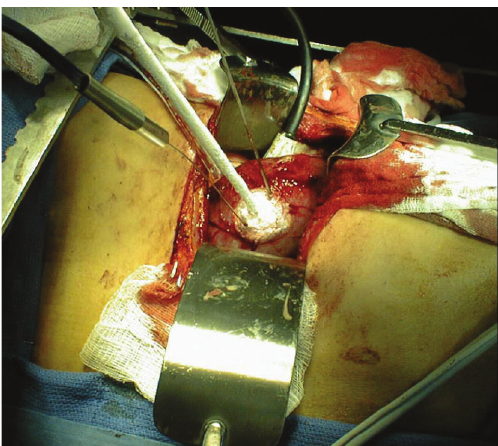
Figure 1: Open renal cryoablation. Cryoprobe with 2 temperature probes are